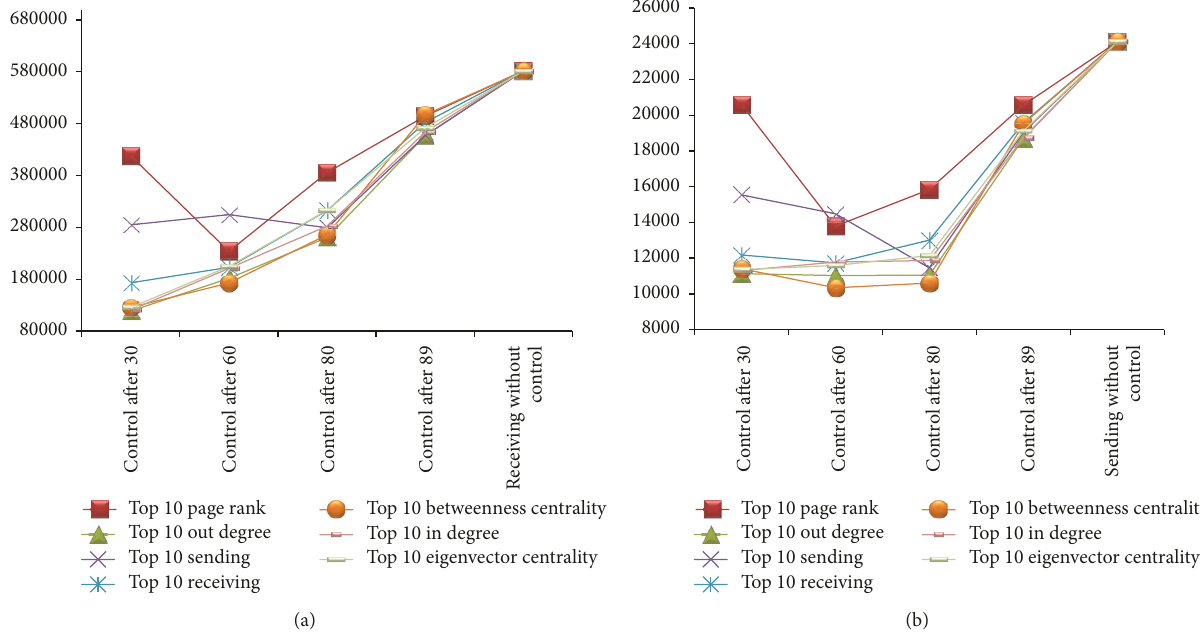
Figure 12: Reduction in receiving and sending by managing key users ((a) is for receiving, and (b) is for